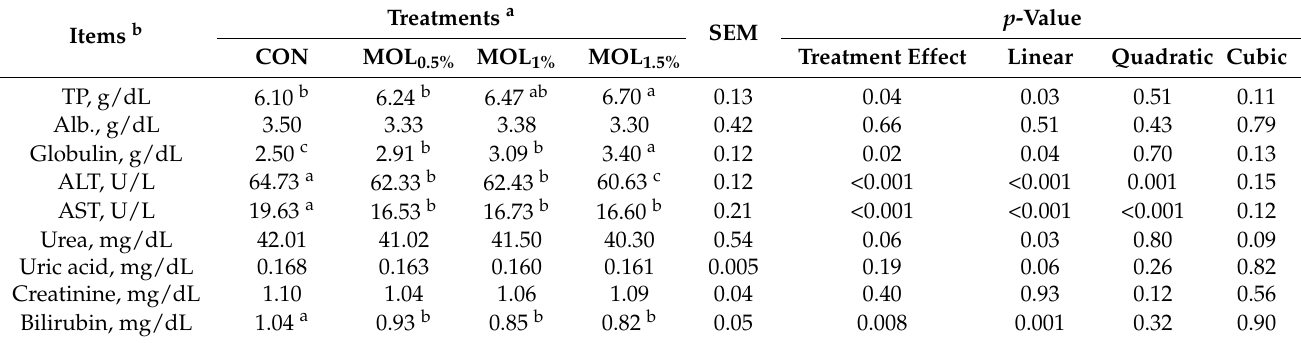
Table 4. Blood biochemical constituents of growing rabbits fed the experimental